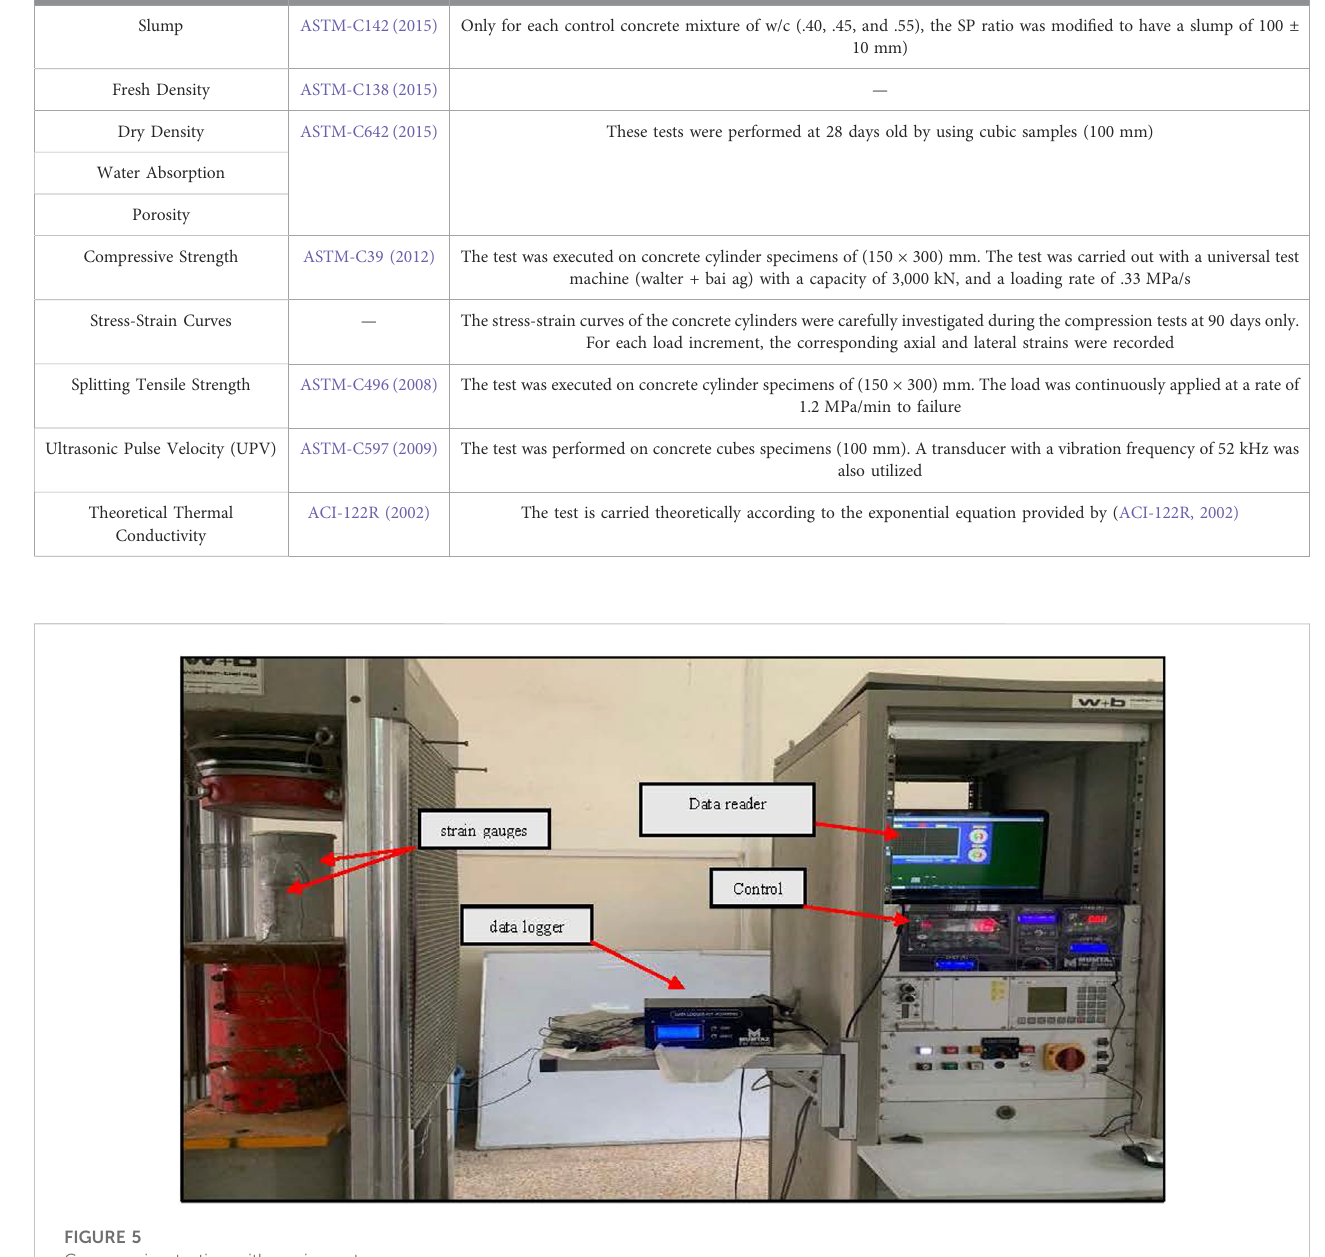
Compression testing with